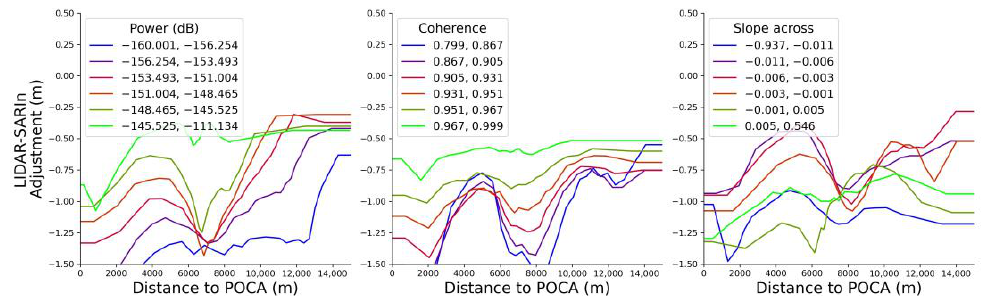
Figure 4. LIDAR-SARIn adjustment as a function of distance to POCA broken down by 6 quantile bands of coherence, power (dB), and slope across.